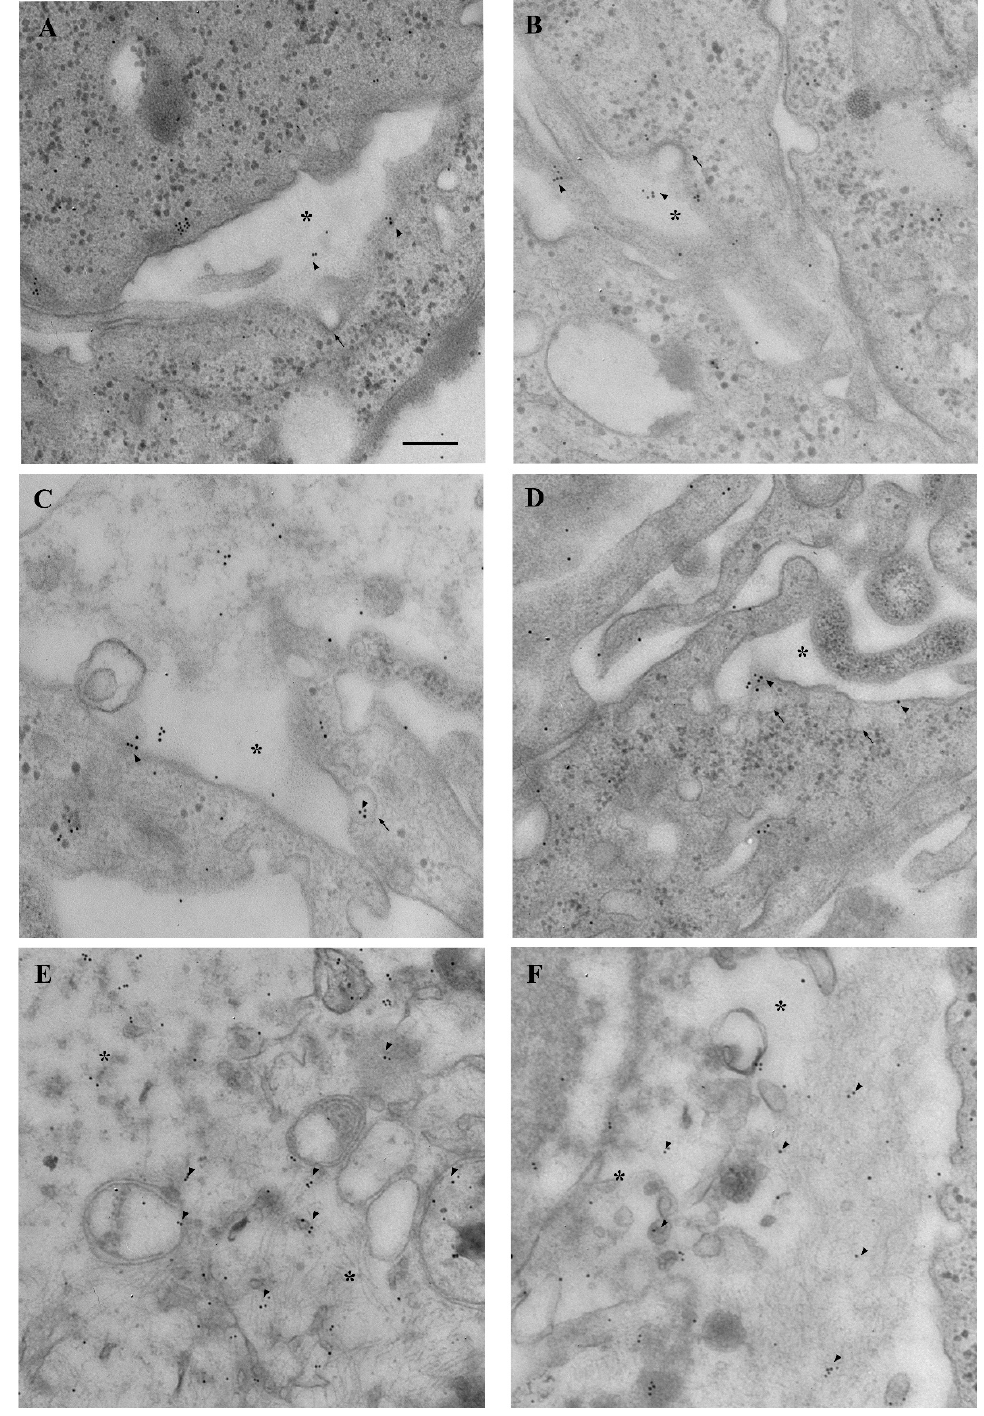
Figure 20. Representative in situ detection of α -syn within supernatant. Ultrastructural immuno- electron microscopy documents the presence of α -syn (arrowheads) as immuno-gold particles. These appear as free molecules ( A ), often close to exocytotic structures (arrow) ( B ) or within cell remnants containing exosome-like structures ( C ), and lying over free-floating membranes (*) ( D – F ). It is remarkable that these structures visualized at TEM possess a size which is compatible with the pore of the semi-permeable membrane of the trans-well system (0.4 μ m). The pictures are taken after scanning the supernatant and they focus on cell membrane-rich areas. Scale bar = 0.12 μ m.